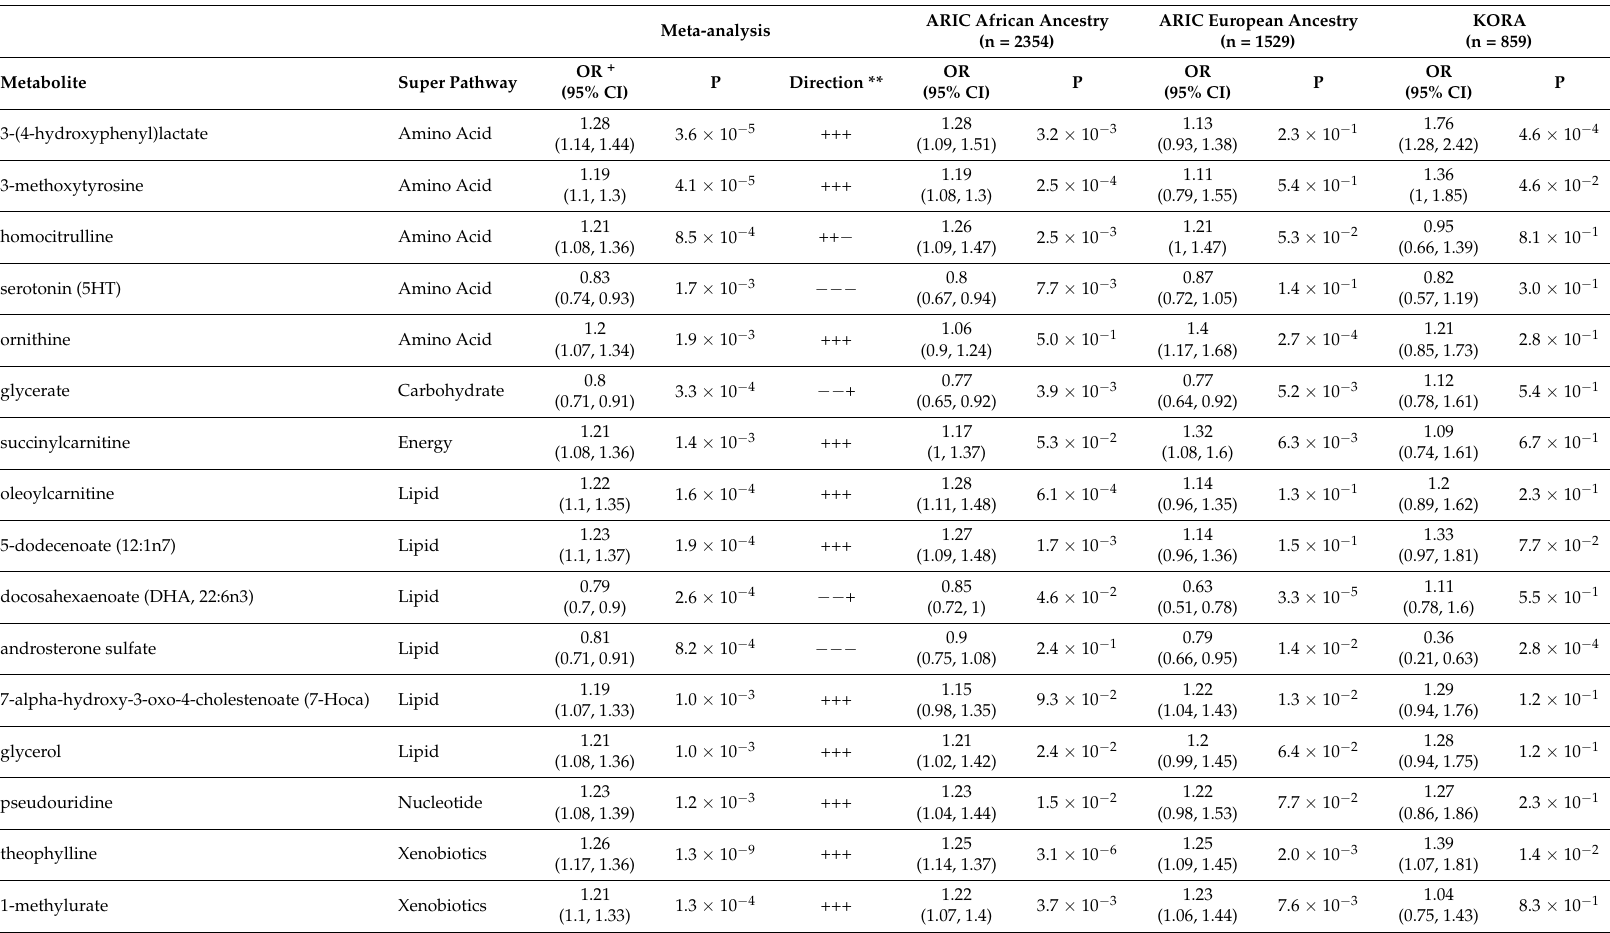
Table 6. Metabolites associated with COPD at FDR < 0.05 in meta-analysis